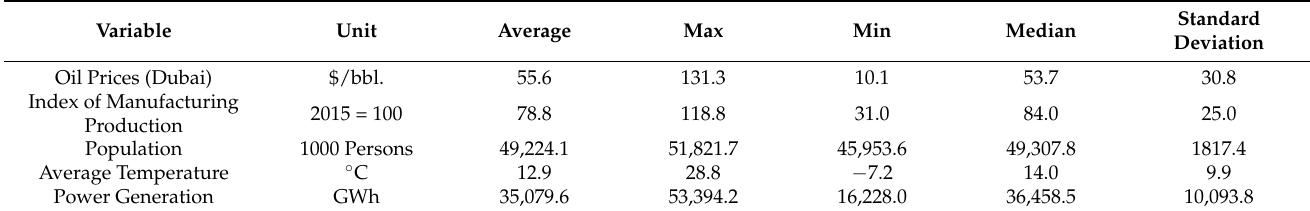
Table 4. Basic statistics of independent